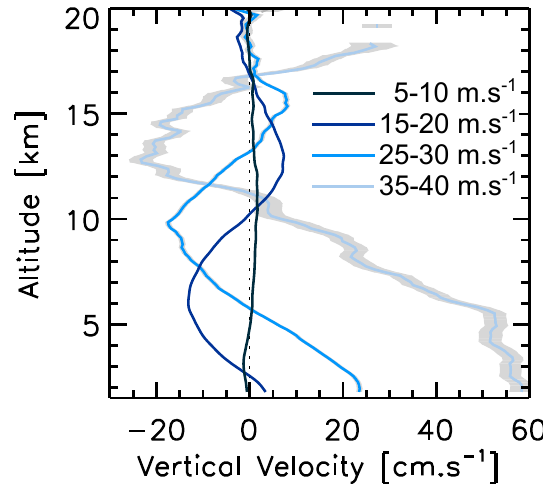
Figure 6. As Fig. 5a but showing the 2km westerly winds, decom- posed into different 2km wind speeds (shown by the